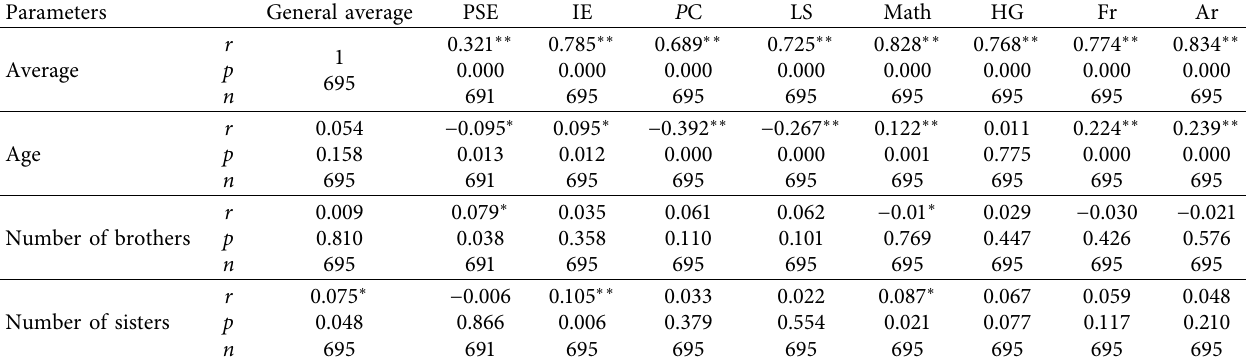
Table 3: Effect of number of brothers and sisters on academic achievement. Parameters